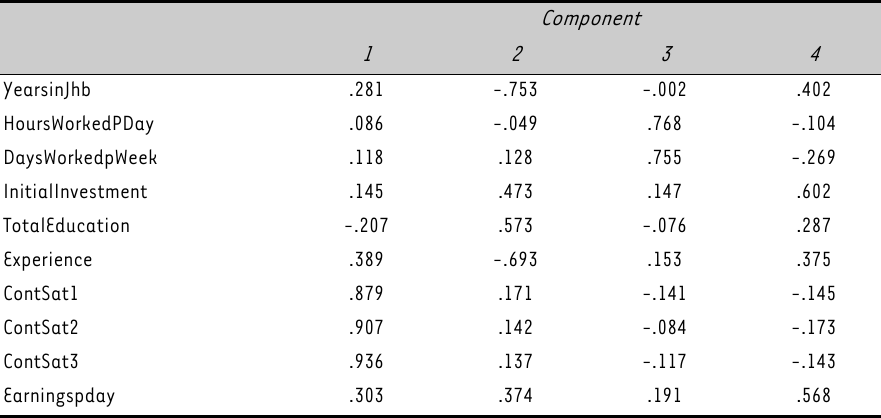
TABLE 1: The Factor Structure: 2010 Component Matrix